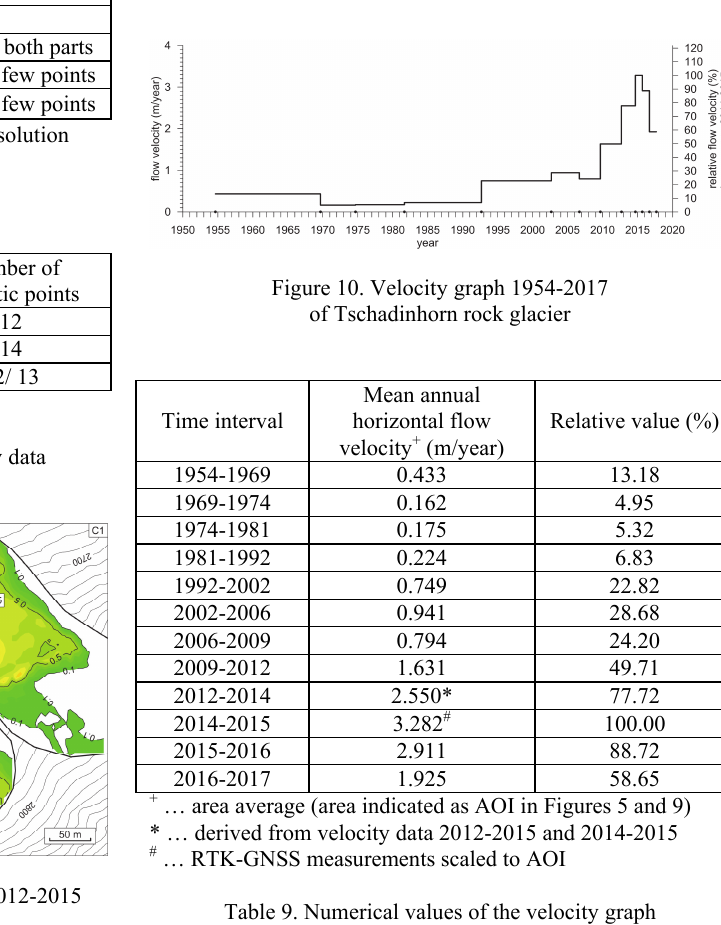
Table 9. Numerical values of the velocity